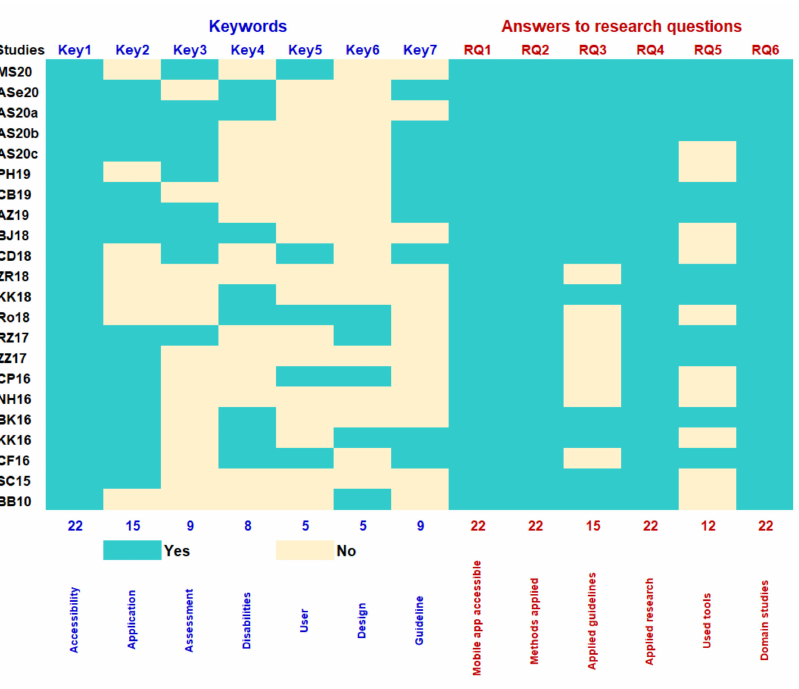
Figure 6. Keywords and answers to the research questions satisfied by the 22 primary studies